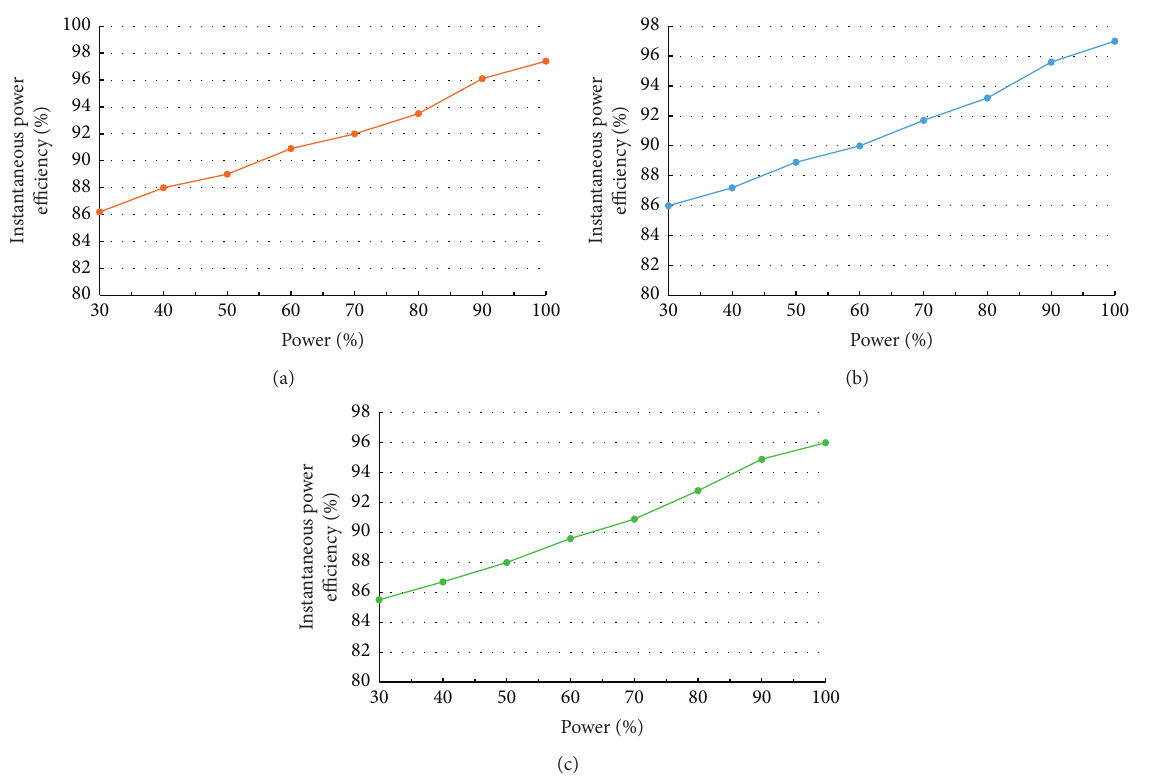
Figure 21: Efficiency curves for different working modes. (a) Efficiency curve of 1S-3L. (b) Efficiency curve of 2S-2L. (c) Efficiency curve of